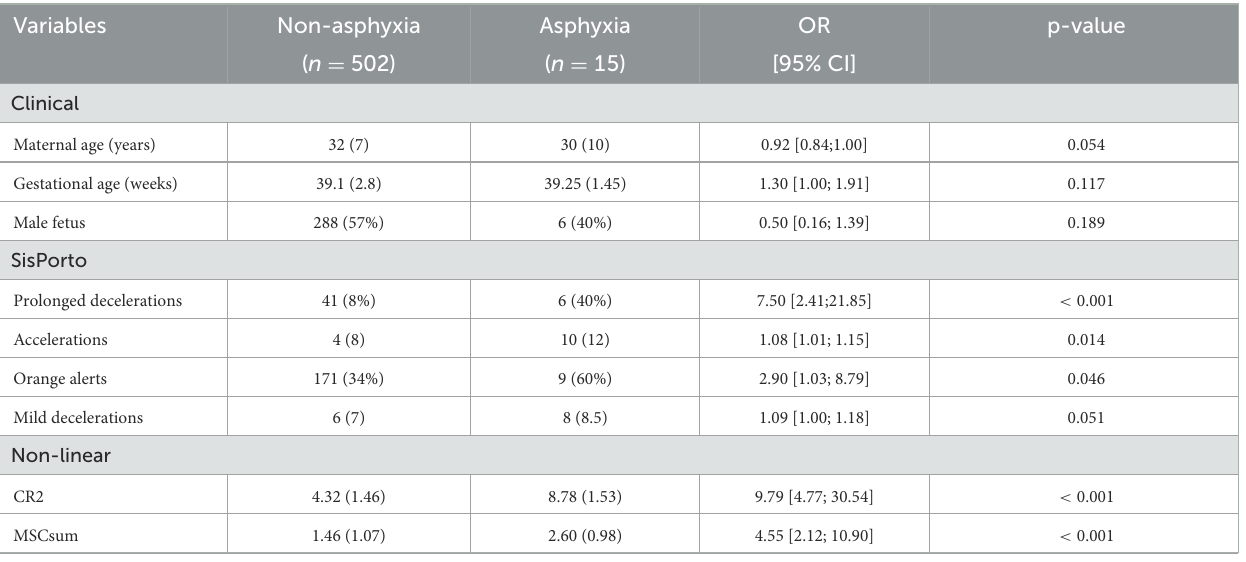
TABLE 2 Non adjusted odds ratio (OR), respective 95 % confidence interval (CI), and p -value for variables with p < 0.2.